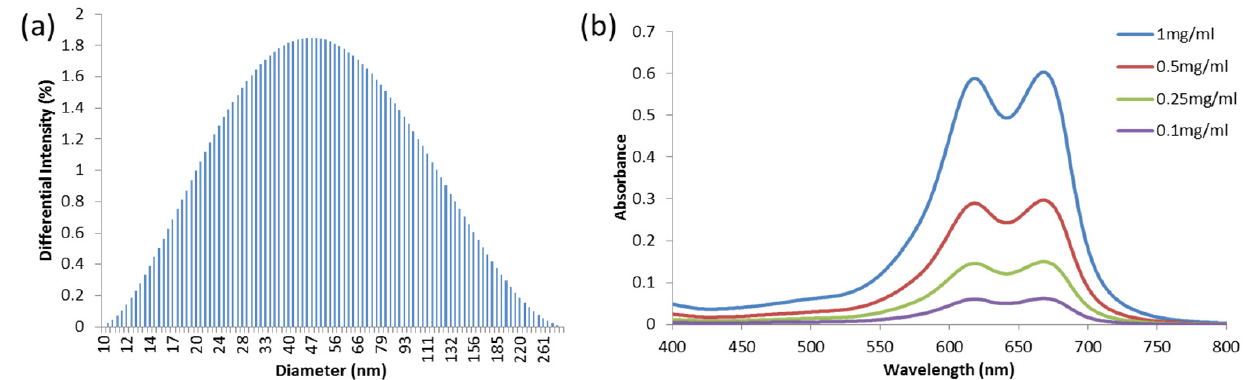
Figure 1. ( a ) Dynamic light scattering (DLS) of MB PAA NPs. ( b ) UV-vis absorption spectra of MB PAA NPs in PBS pH 7.4 buffer for different concentrations (0.1, 0.25, 0.5, and 1 mg/mL).